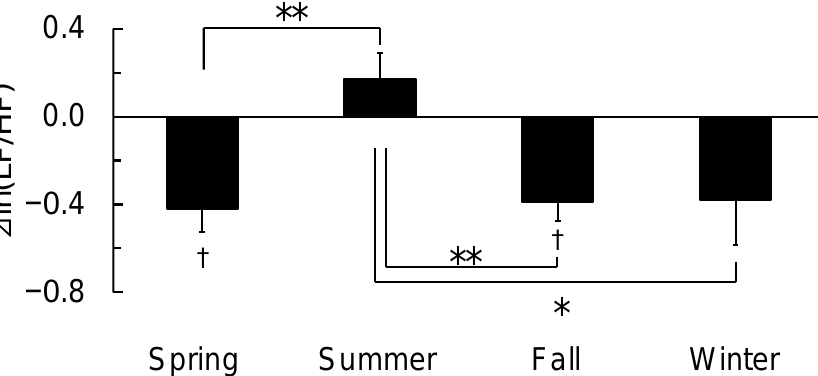
Figure 4. Differences in the changes in ln(LF/HF) walking in an urban park and in a city area according to the four seasons. n = 51 (spring: n = 12, summer: n = 12, fall: n = 20, and winter: n = 7); mean ± standard deviation, †: p < 0.05 using the paired t -test (urban park vs. city area); *: p < 0.05; and **: p < 0.01 using one-way analysis of variance with the post-hoc test (four